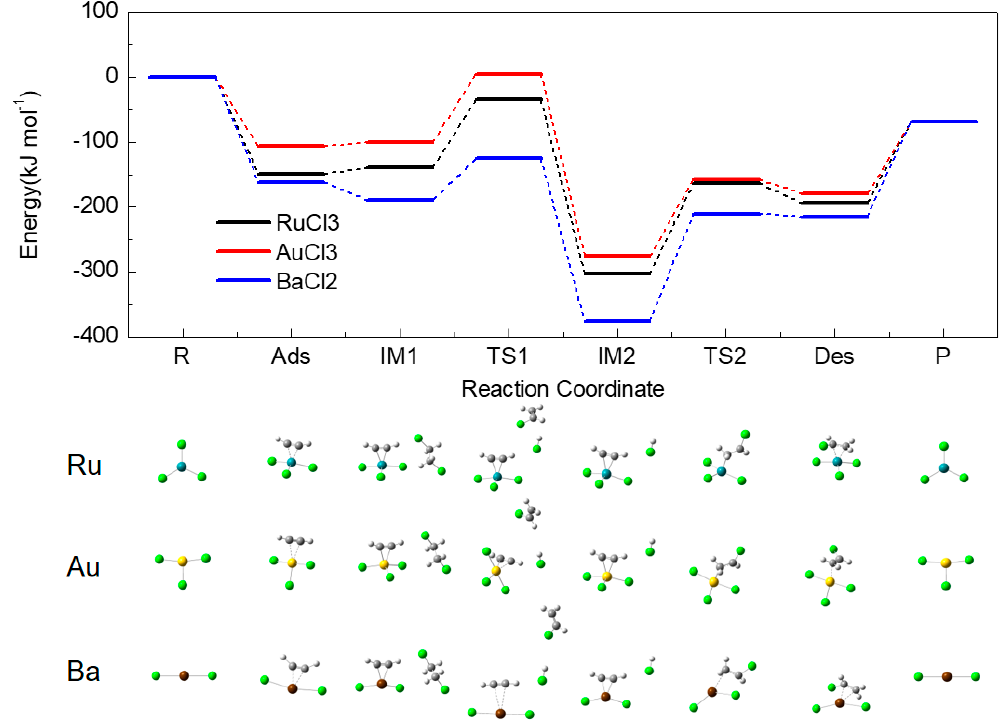
Figure 3. Energy profiles and corresponding structures of species for DCE-exchange reaction: acetylene-DCE complex pathway. Free molecules of DCE, C 2 H 2 , HCl, and VCM are omitted for clarity.